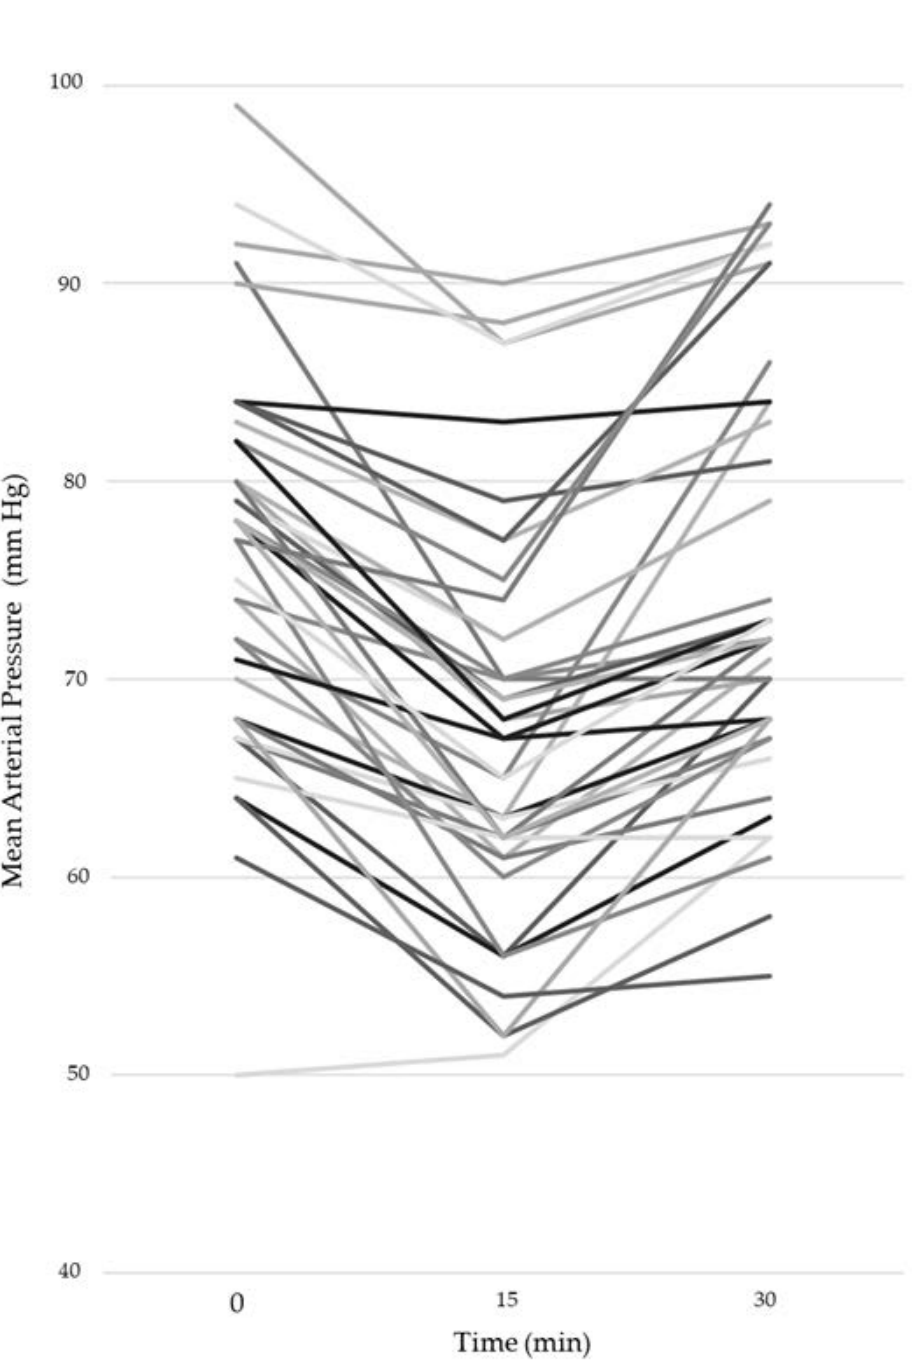
Figure 1. Mean Arterial Pressure changes at baseline, after 15 min and after 30 min from nore- pinephrine infusion